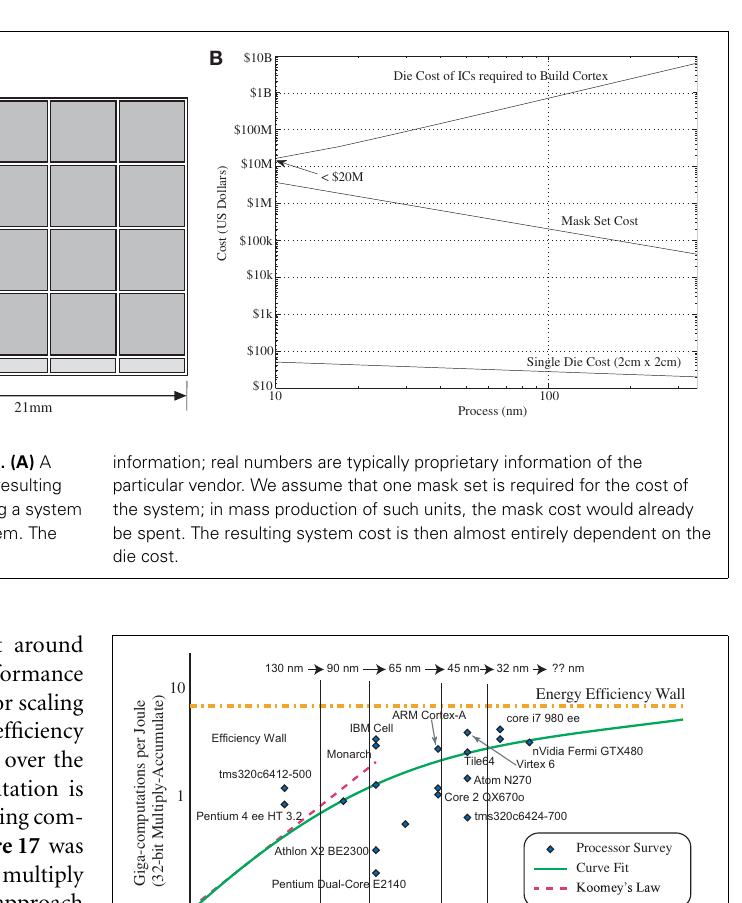
Processor Survey Curve Fit